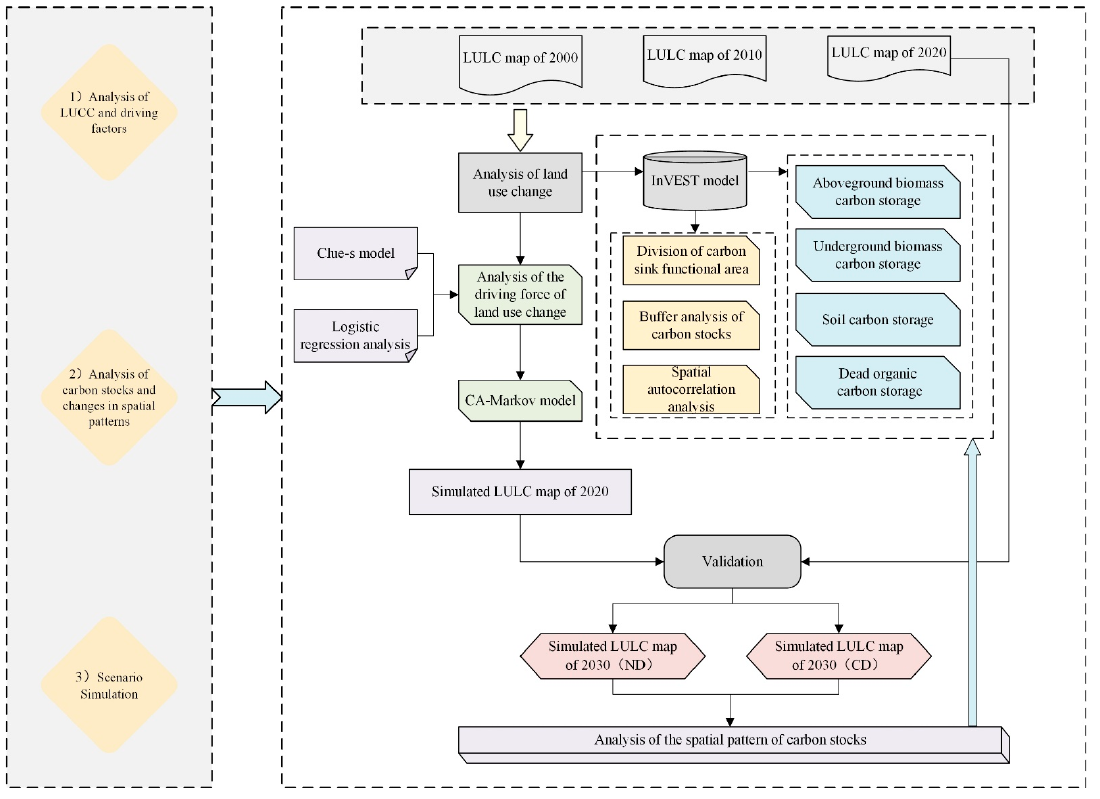
Figure 1. Methodological framework applied for simulating current and future carbon stocks of Changzhi city in Shanxi, China.